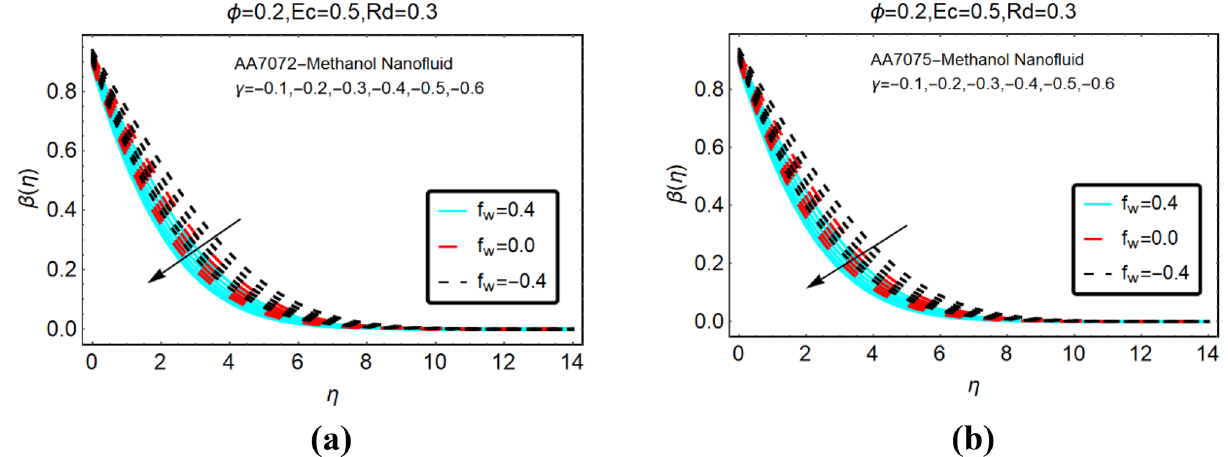
Figure 9. The effects of heat absorption on ( a ) AA7072-Methanol ( b ) AA7075-Methanol.